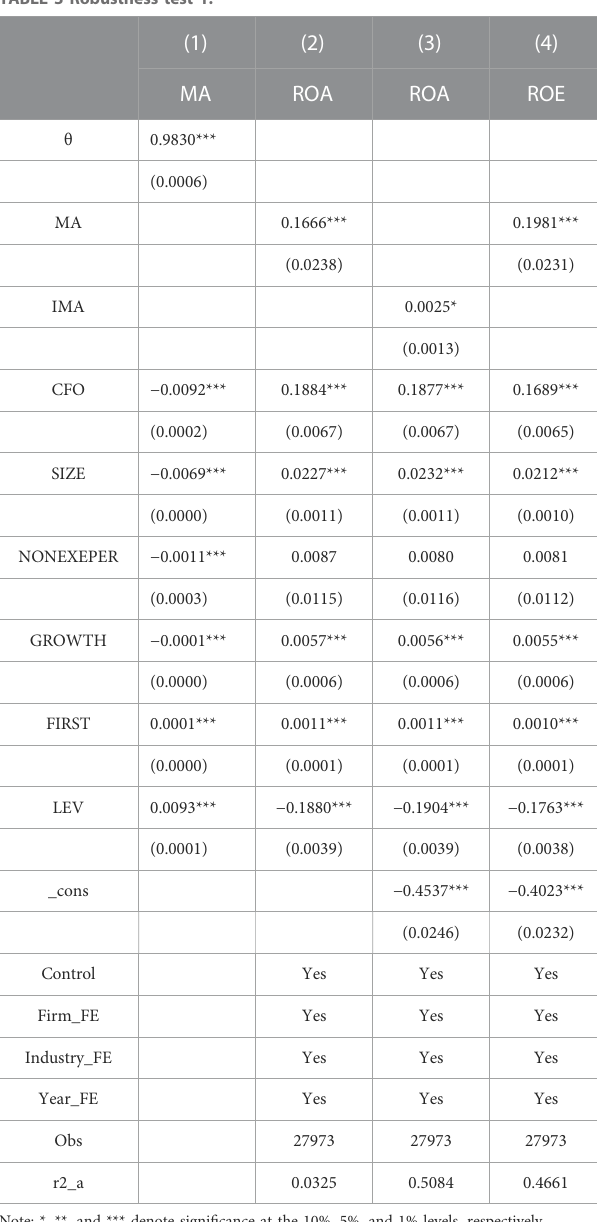
Table 1. The mean values of management ability (MA) and enterprise performance (ROA) are 0.008 and 0.048, respectively.